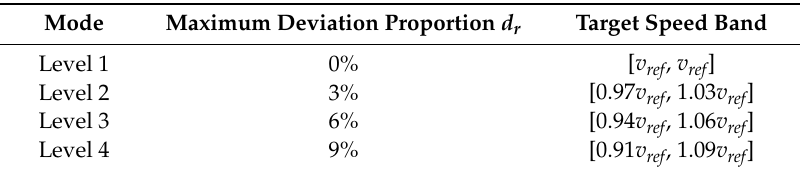
Table 1. Speed deviation